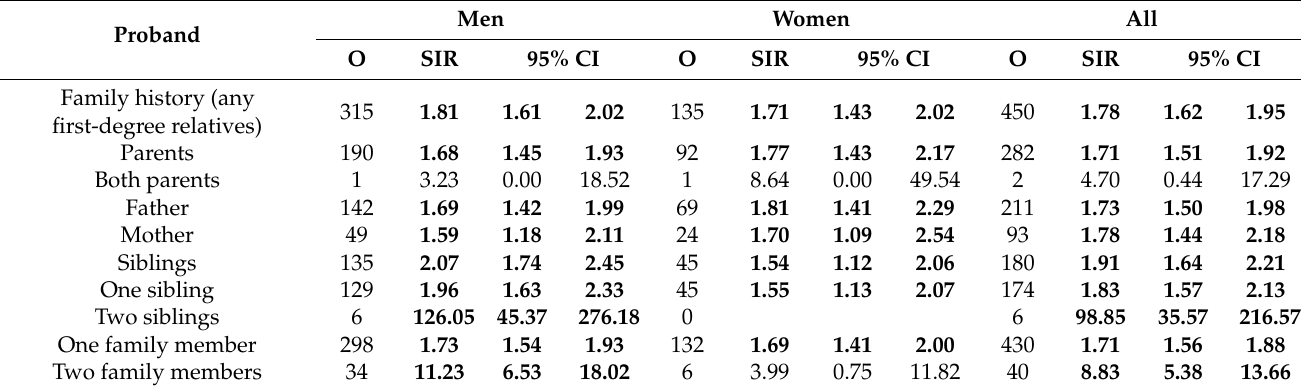
Table 1. Familial risk of head and neck cancers when first-degree relatives were diagnosed with head and neck cancers. Proband